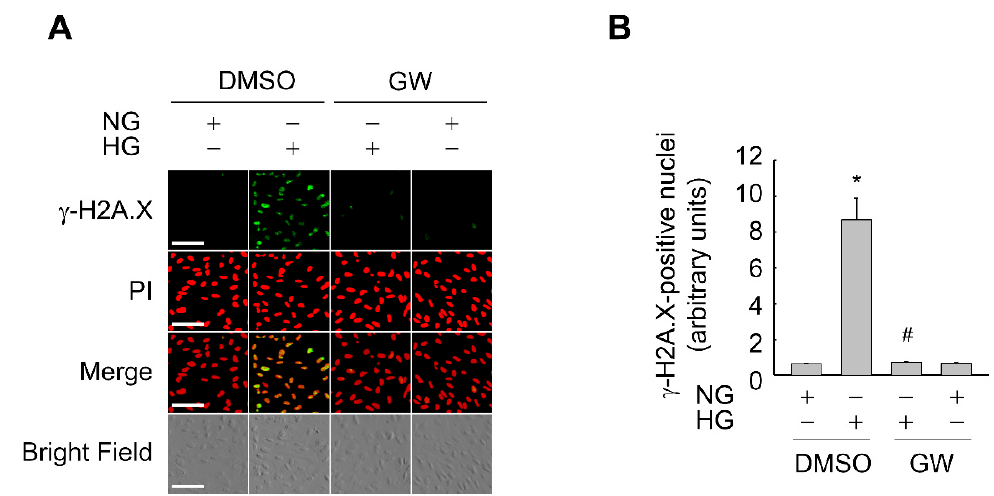
Figure 4. Ligand-activated PPAR δ inhibits the HG-induced increase in the number of γ -H2A.X foci in ARPE-19 cells. ( A , B ) Cells pretreated with a vehicle (DMSO) or 100 nM GW501516 (GW) for 24 h were exposed to NG (5.6 mM) or HG (30 mM) for 48 h. Representative images from four independent analyses are shown ( A ). Scale bars indicate 100 µ m. Cells were selected from at least four randomly chosen fields and γ -H2A.X-positive nuclei were scored ( B ). Data are expressed as means ± S.E. ( n = 4). * p < 0.01 compared with the NG-treated group. # p < 0.01 compared with the HG-treated group.